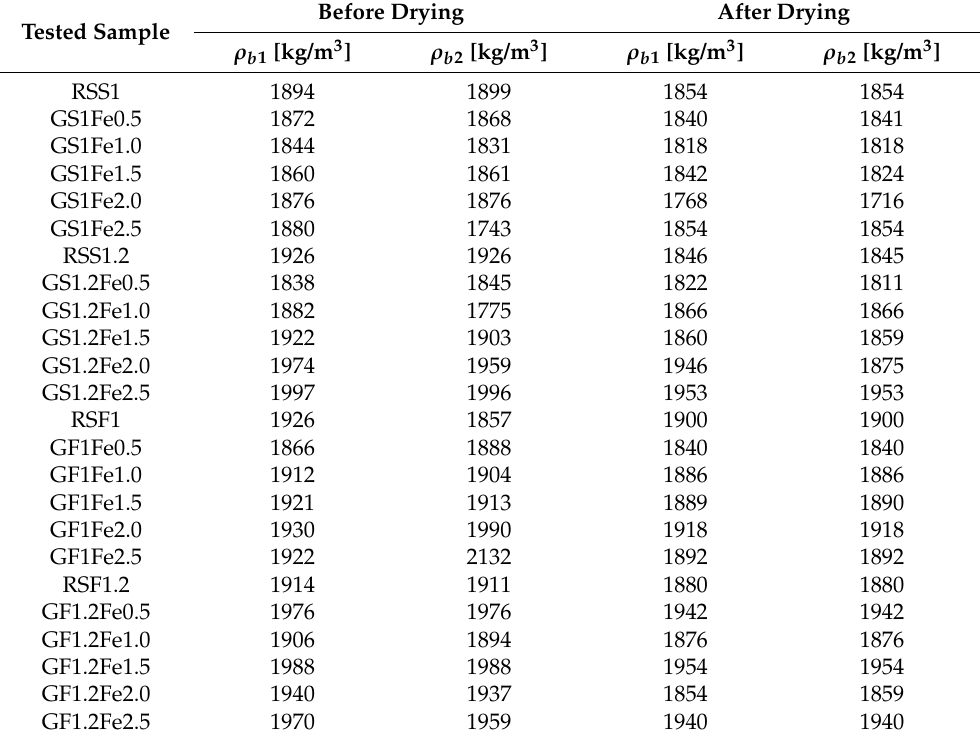
Table 2. The calculated bulk density ρ b 1 and ρ b 2 of the tested samples. Before Tested Sample